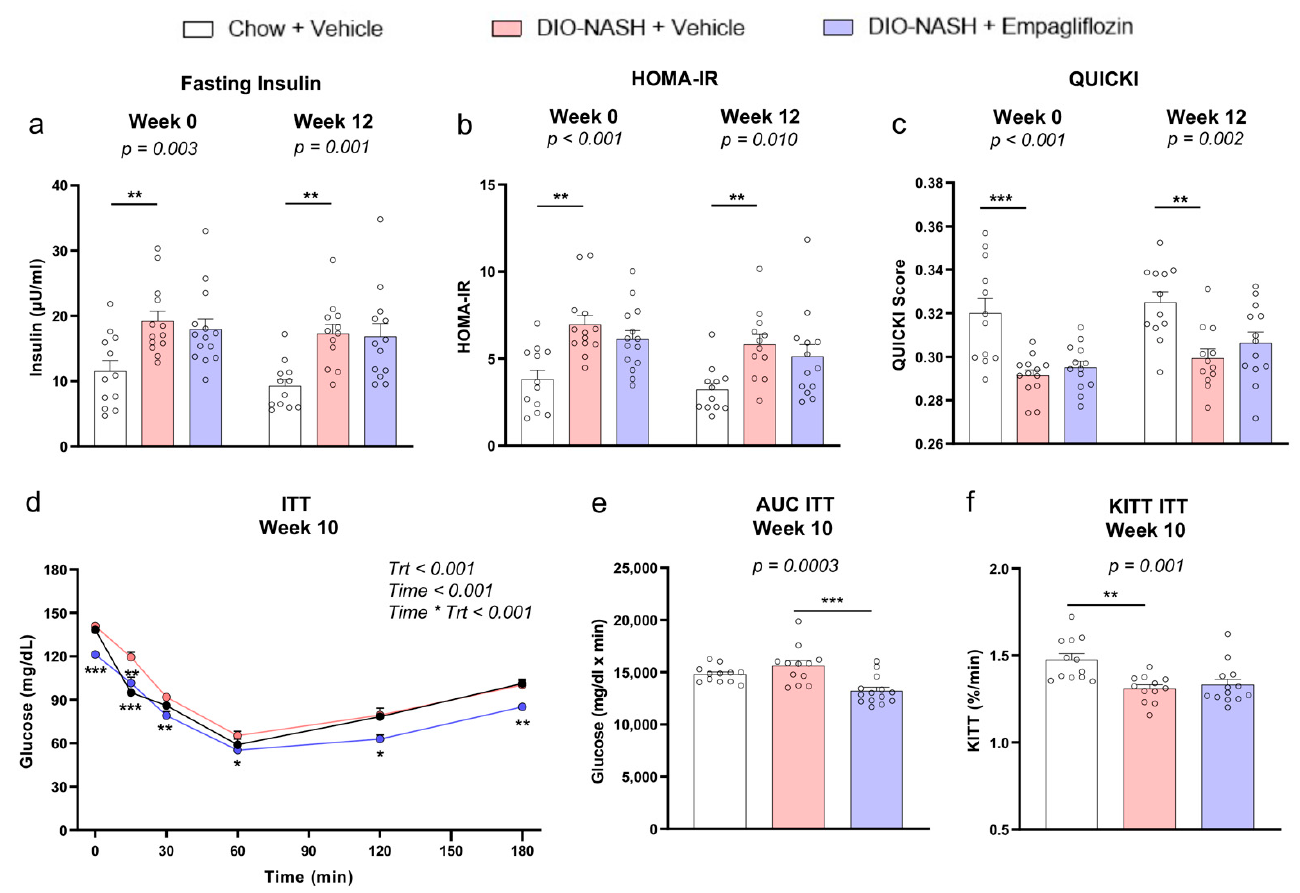
Figure 3. Empagliflozin does not improve insulin sensitivity in DIO-NASH insulin-resistant mice. ( a ) Insulin levels after 4 h fasting, ( b ) HOMA-IR and ( c ) QUICKI score at week 0 (start of treatment) and week 12 (completion of treatment). ( d ) Glucose levels, ( e ) AUC and ( f ) KITT in the ipITT at week 10. A two-way ANOVA was performed for the ipITT and p -values are reported for Trt, treatment (Chow + vehicle, DIO-NASH + vehicle, DIO-NASH + empagliflozin), Time (minutes of ITT) and their interaction Time * Trt. A one-way ANOVA was performed for all of the other parameters ( a – c , e , f ). The AUC and p of the ANOVA are reported. By p < 0.05 in Trt * Time for the ipITT and in the ANOVA for the other parameters, post-hoc Dunnett tests were performed in each timepoint in the ipITT, at week 10 in the AUC ITT and KITT ITT and at week 0 and week 12 in the fasting insulin, HOMA-IR and QUICKI and * p < 0.05, ** p < 0.01, *** p < 0.001, respectively, for Chow + vehicle or DIO-NASH + empagliflozin compared with DIO-NASH + vehicle. Data show means ± SEMs. AUC, area under the curve. N = 12 for Chow + vehicle and n = 13 for DIO-NASH + vehicle and DIO-NASH +